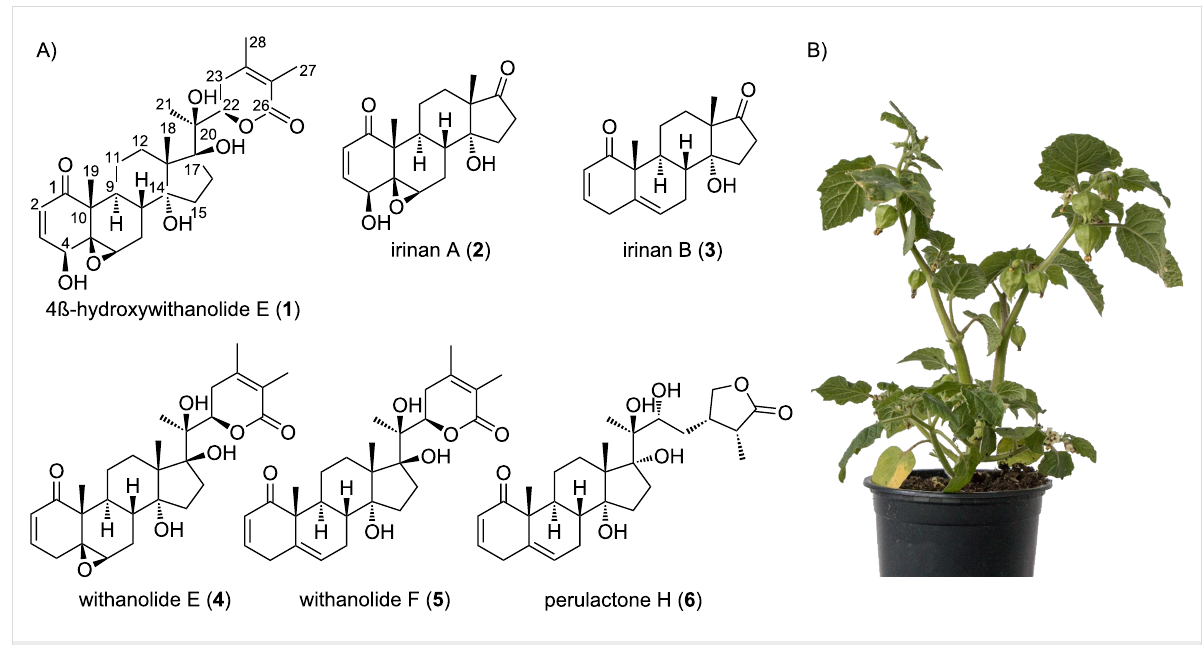
Figure 1: Withanolides from Physalis peruviana . A) Structures of the newly characterised truncated withanolides irinan A ( 2 ) and B ( 3 ) with an androstane backbone, together with the known withanolides 1 and 4 – 6 isolated from P. peruviana . B) P. peruviana